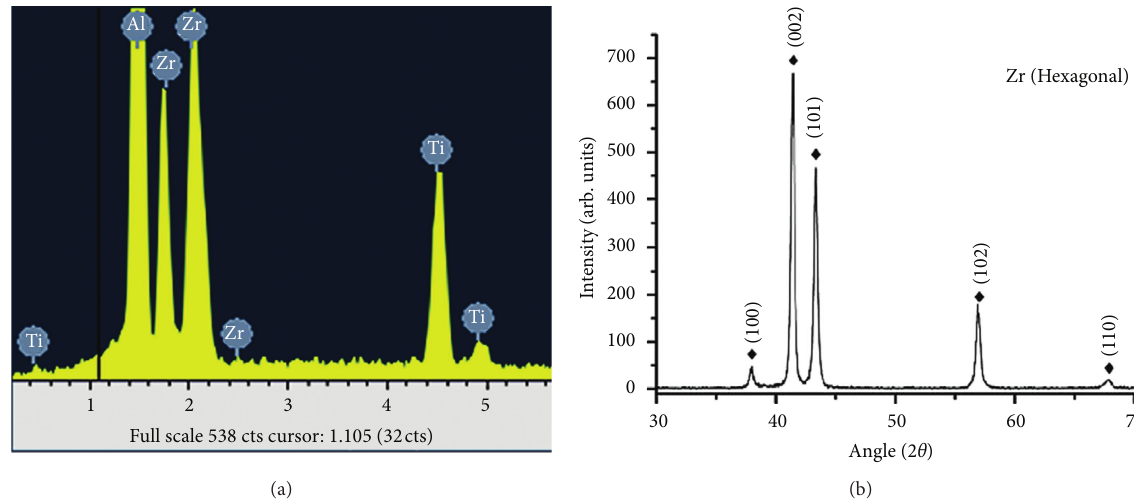
Figure 6: (a) EDS spectrum corresponding to white circled area in Figure 5(b) showing strong reflections from Al, Zr, and Ti and (b) X-Ray diffraction spectrum for zirconium metal